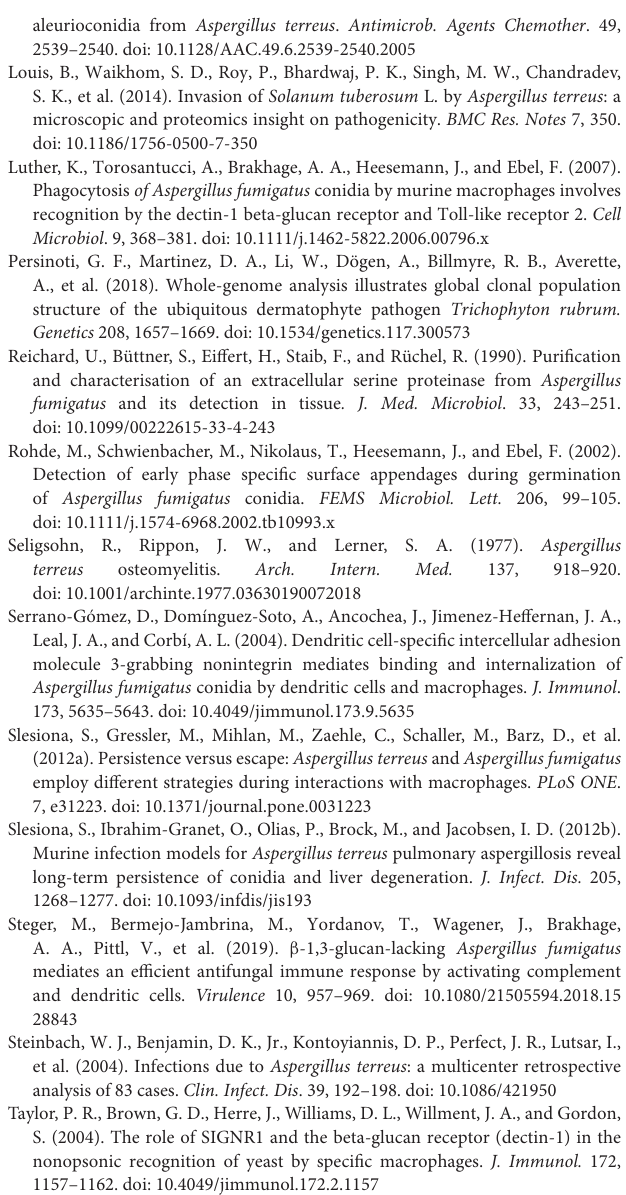
the A. fumigatus strain D141 was compared in Sabouraud and cell culture medium [ (A,B) , respectively]. After 1, 3.5, 7, and 9h, samples were analyzed microscopically and the percentages of resting conidia, swollen conidia, germlings, and hyphae were determined. For each measurement, three groups with 100 conidia each were analyzed. Standard deviations are indicated. Supplementary Figure 3 | Staining of an AC of strain At17-14 with the galactomannan-specific mab L10-1 (red) and Calcofluor white (blue). (A–G) show a sequence of confocal optical planes. The corresponding maximum intensity project is depicted in (H) . Sites of emerging germ tubes are indicated by arrows in (A,F) . A germ tube that was initially formed is indicated by an arrow in (D) . The bar in H represents 5 µ m and is valid for all panels. Supplementary Figure 4 | Representative images depicting the different stages of the germination process that were differentiated in the quantitative analysis. The bar represents 10 µ m and is valid for all